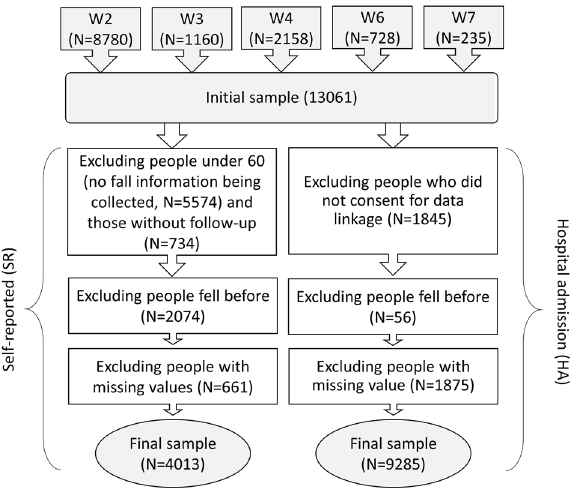
Figure 1. Sample selection diagram for the self-reported (SR) cohort and the hospital admission (HA)